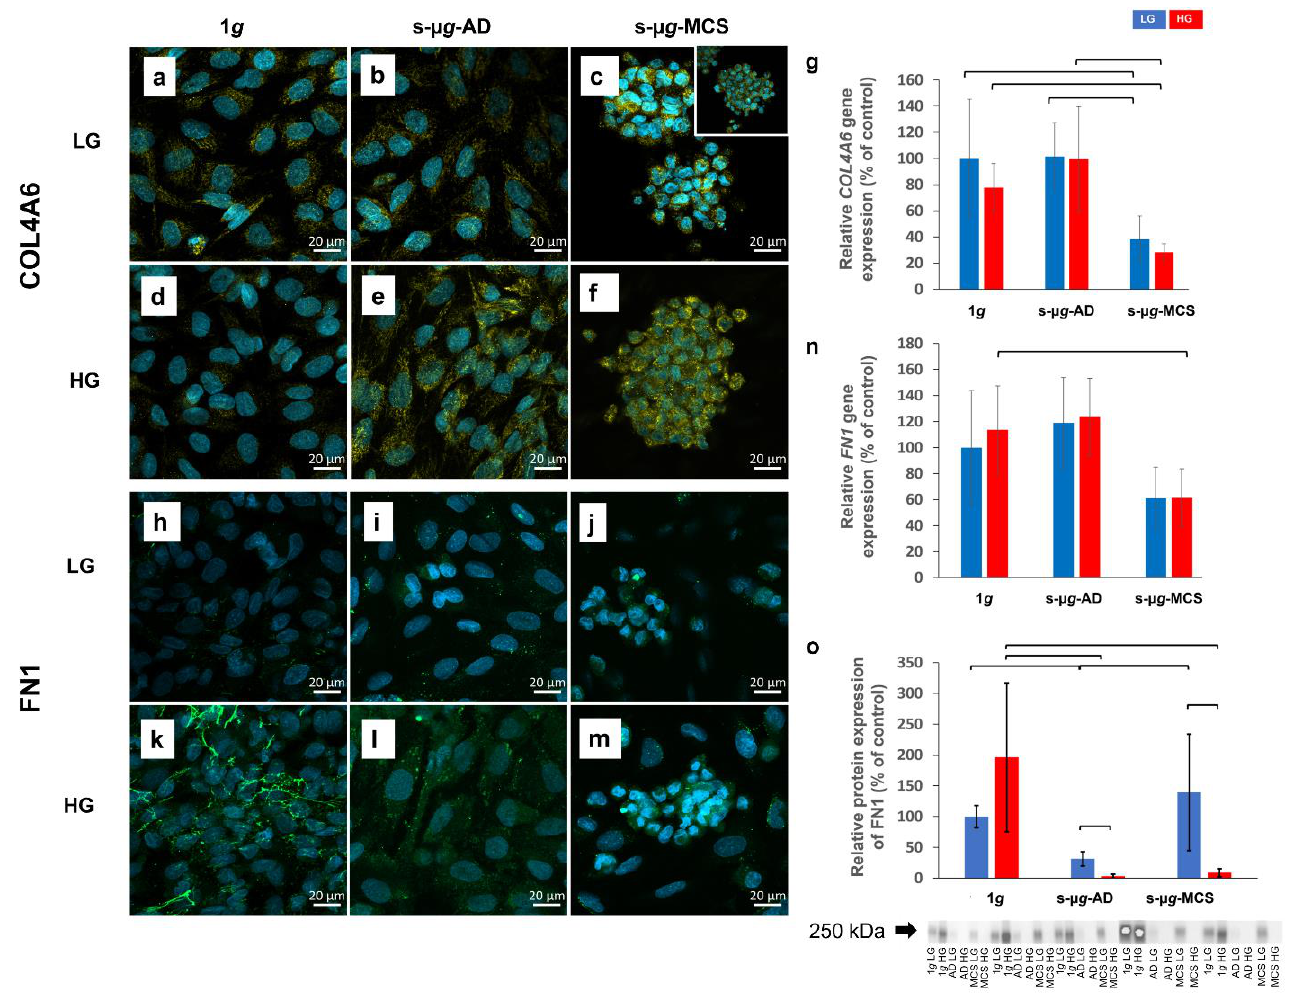
Figure 2. Analysis of the ECM proteins collagen IV ( a – g ) and fibronectin ( h – o ) after 14 days of cultivation either at 1 g or s- µ g and either using low (LG) or high (HG) glucose medium. In the presentation of the s- µ g samples, a differentiation was made between AD and MCS. The data were detected via immunostaining ( a – f , h – m ), qPCR ( g , n ), and Western blot techniques ( o ). The brackets represent a significance level of p <